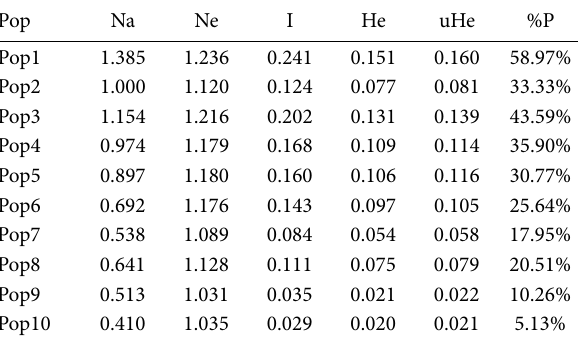
Table 3. Genetic diversity parameters in the studied populations (N = number of samples, Na= number different alleles, Ne = number of effective alleles, I= Shannon’s information index, He gene diver- sity, UHe = unbiased gene diversity, P%= percentage of polymor- phism).